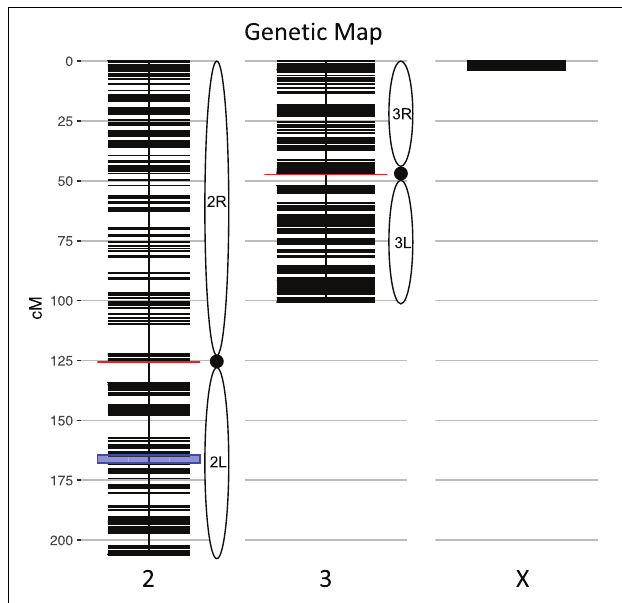
FIGURE 1 | Genetic map of the An. coluzzii × An. quadriannulatus backcross showing centromere locations (red horizontal lines) and marker locations (black horizontal lines). The centromere of the telocentric X chromosome is opposite zero cM. The blue highlighted area on chromosome 2 indicates the location of the 2L a inversion in An. coluzzii